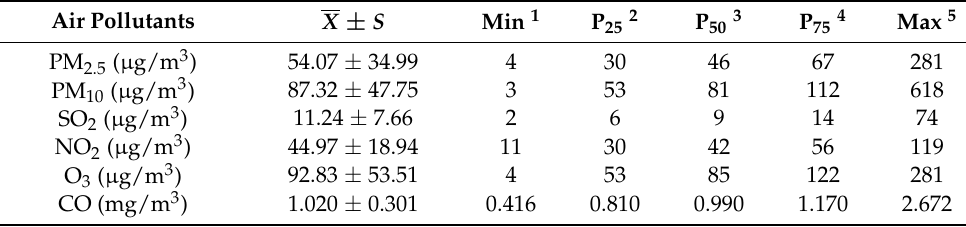
Table 7. Basic Information for the period of 2015–2019 for air pollutants in Wuhan.